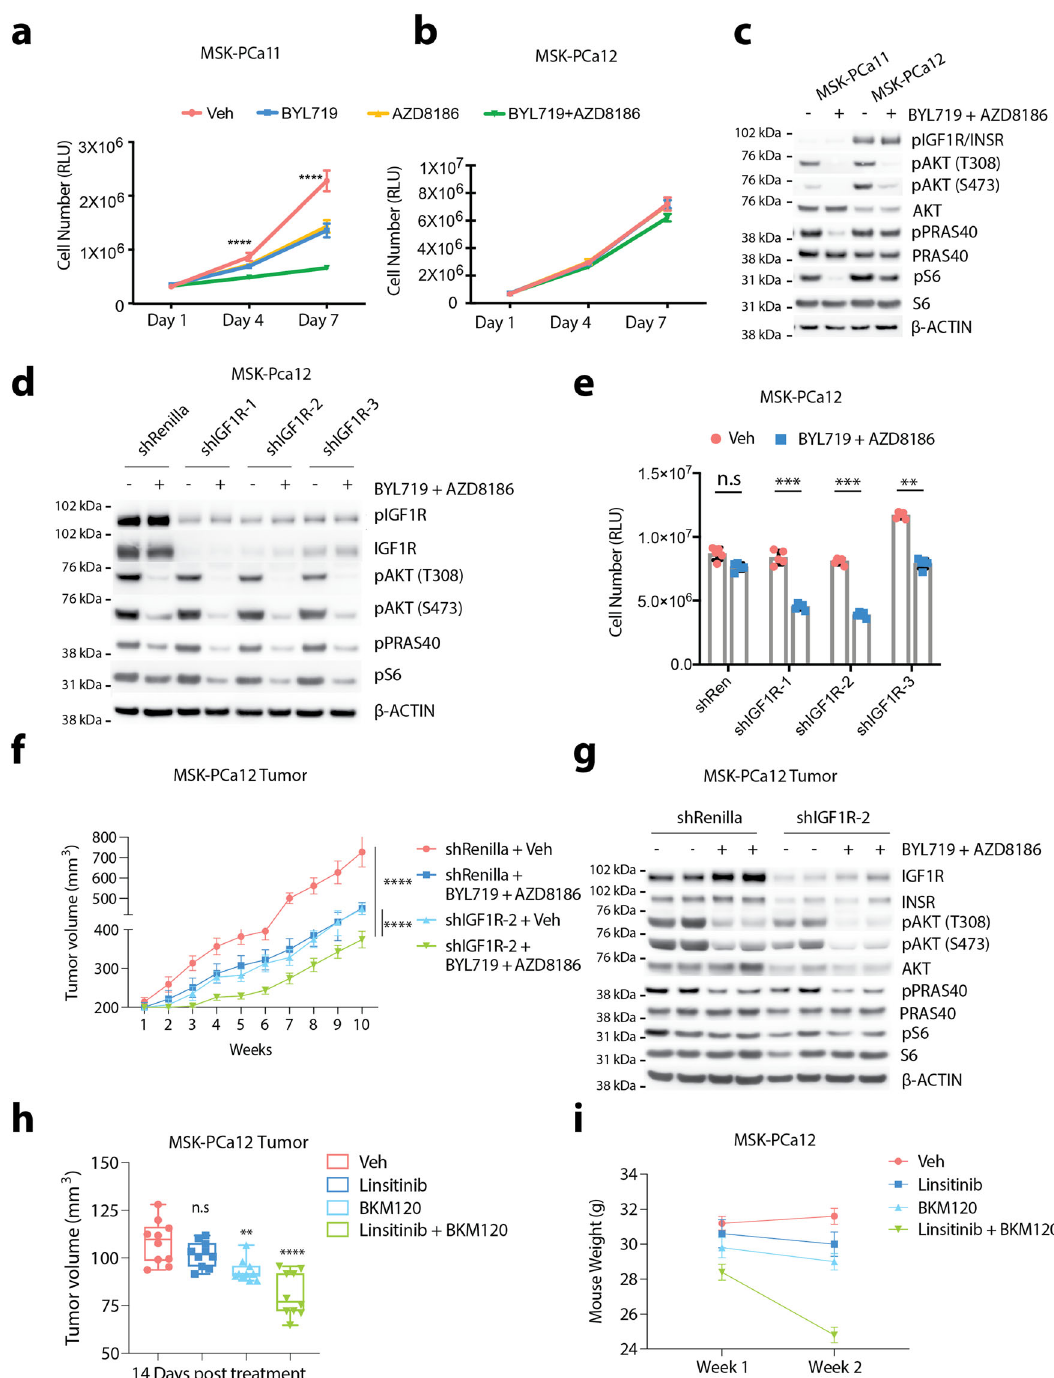
directly compare the ef fi cacy of PI3K to AKT inhibition in hormone-regulated cancers, we evaluated a panel of prostate and breast cancer models harboring alterations in the PI3K signaling pathway. In the setting of wild-type PTEN where PI3K signaling was activated through PIK3CA mutation or RTK signaling, PI3K pathway inhibition with p110 α + p110 β was generally more anti- proliferative than AKT inhibition (Fig. 5f). However, in the setting of PTEN -loss (endogenous or isogenic PTEN knockout pairs), AKT inhibition showed greater ef fi cacy at suppressing cell growth than PI3K inhibition even when p110 α activating mutations were present (Fig. 5g). This association was especially signi fi cant for the breast cancer cell lines harboring mutant